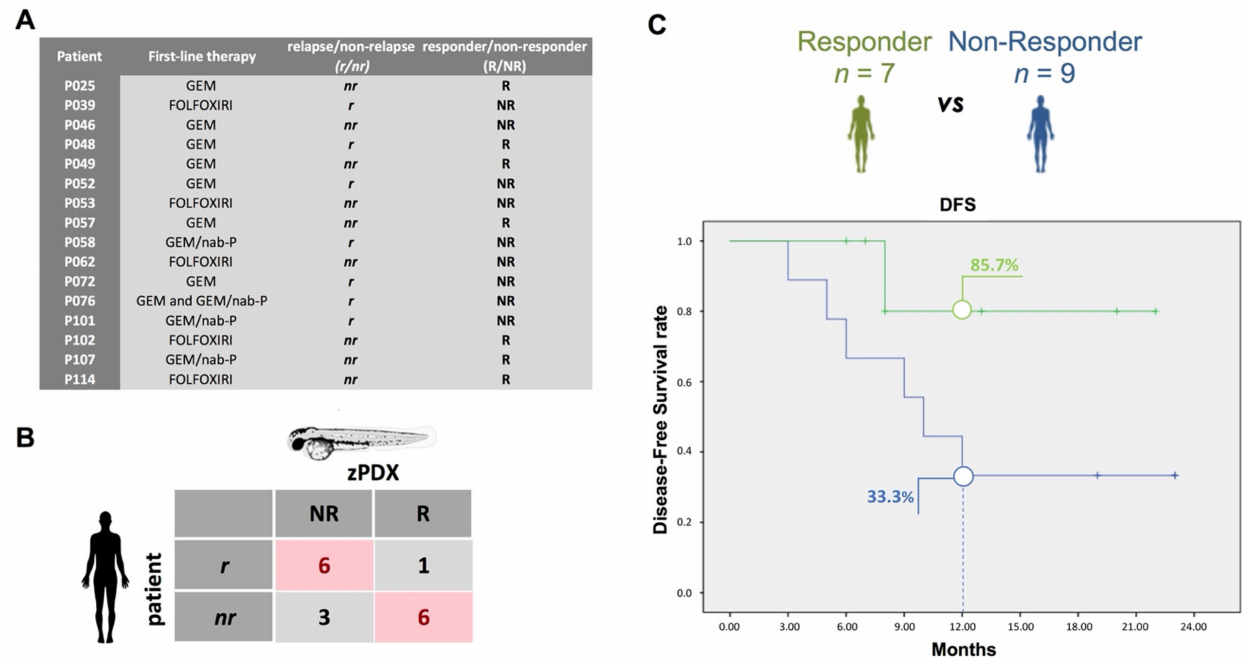
Figure 4. Analysis of the follow-up data in comparison to the prediction of the zPDX. ( A ) Relapse/non-relapse (r/nr) information for 16 PDAC patients enrolled in Table 2 versus the respective responder/non-responder (R/NR) zPDXs. We considered relapse when the patient has the clinical evidence of recurrence within one year after surgery. The zPDX treatment response may predict an early relapse (r) or a better response to therapy (non-relapse, nr). Sixteen PDAC zPDX, corresponding to patients subjected to curative surgery and postoperative adjuvant treatment, were treated with GEM, GEM/nab-P, GEMOX and FOLFOXIRI for 2 days. The zPDX response to treatment was analyzed and quantified adapting the WHO criteria for tumor response. We considered responder (R) zPDX with a decrease ≥ 50% in the relative tumor area. ( B ) Confusion matrix highlights the number of no cancer relapse (nr) in patients with the own responder (R) zPDX and the number of cancer relapse (r) in patients with the own non-responder (NR) zPDX. ( C ) Disease-free survival difference in R group (green) and NR group (blue), p = 0.123 by log-rank